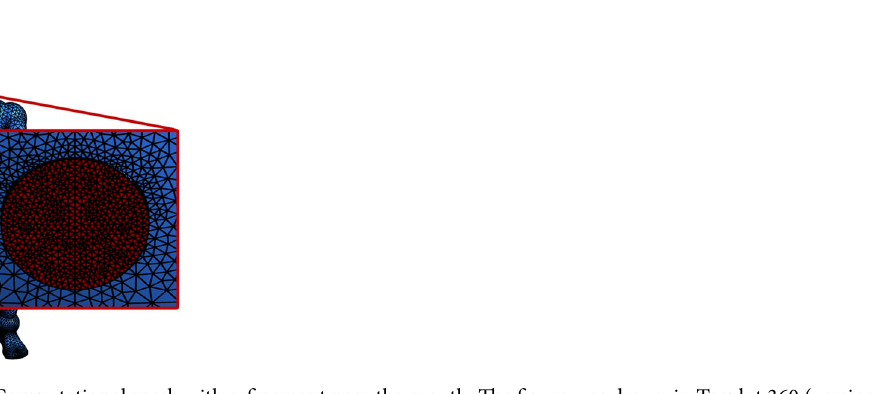
Figure 2. The computational domain dimensions and vertical planes. The figure was drawn in Tecplot 360 (version 2016 R2) and Adobe Illustrator (version 16.0).